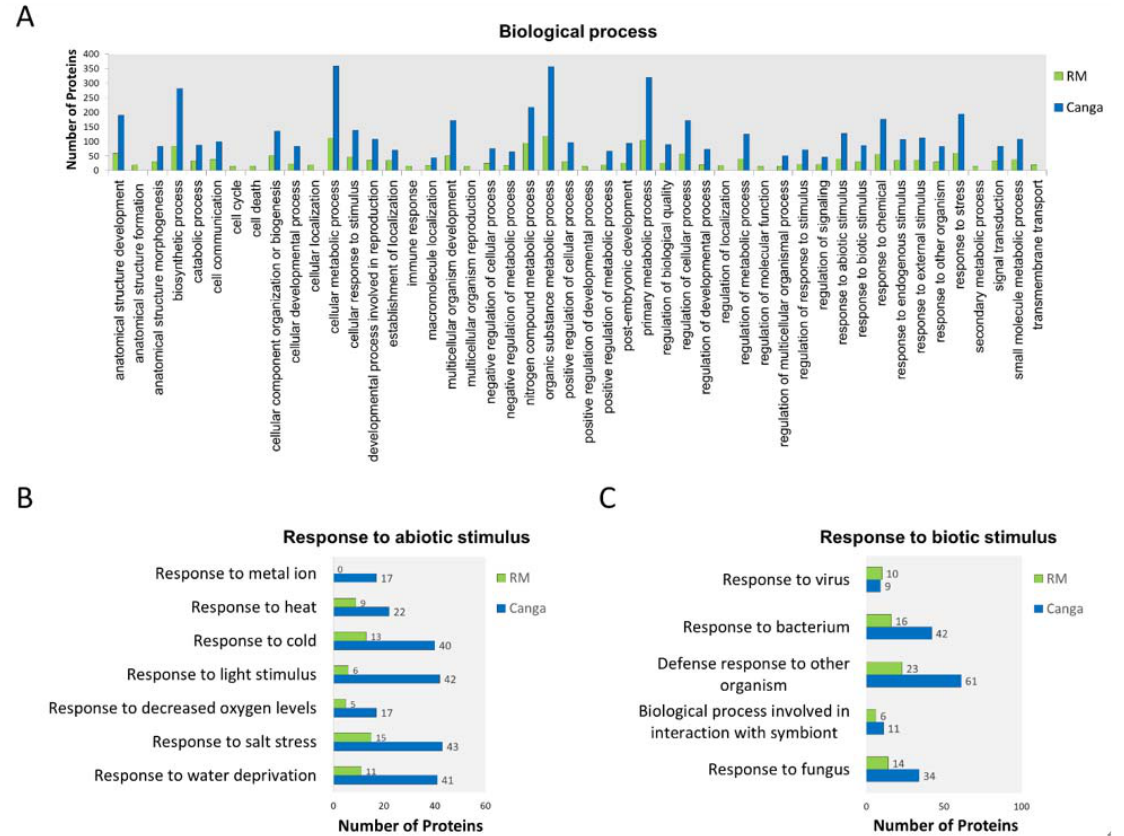
Figure 2. Gene Ontology (GO) annotation of differentially abundant proteins identified in M. acutistipula sampled from RM and canga . ( A ) GO annotation showing the GO terms in the category of biological process of more abundant proteins in plants from RM or canga . ( B ) Subgraph of the term response to abiotic stimulus. ( C ) Subgraph of the term response to biotic